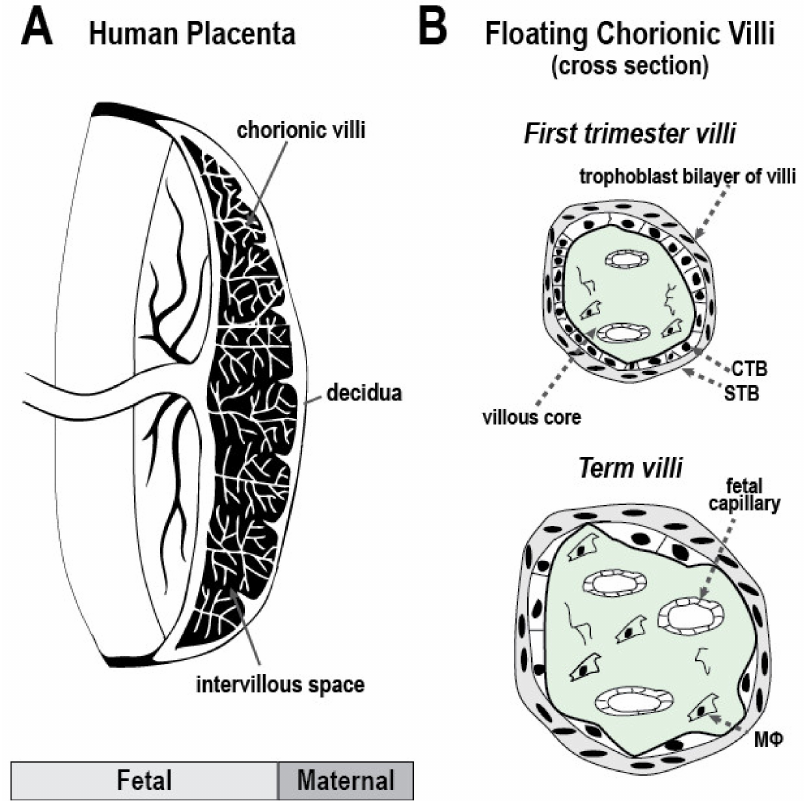
Figure 1. Human placenta and chorionic villi. The placenta ( A ) is the site of xenobiotic transfer from the mother to the embryo/fetus—an important barrier for environmental chemicals. Chorionic villi ( B ) are covered by an outer layer of fused, multinucleated syncytiotrophoblasts (STB) and an inner layer of villous cytotrophoblasts (CTB). The villous core consists of the basal lamina, mesenchymal cells, residing Hofbauer cells (M Φ ), and fetal capillaries. The architecture and function of the placenta evolves over gestation to support the fetus. In the first and second trimesters, a trophoblast bilayer lines the villus, and invading CTBs differentiate to anchor and establish placental blood flow from the uterus. By the third trimester, nutrient exchange is primary, as well as the support and protection of the fetus. At term, chorionic villi contain more capillaries and immune cells, and fewer invasive CTBs. The legend on the bottom left of ( A ) denotes the fetal-facing amnion (light grey) and maternal-facing chorion (dark